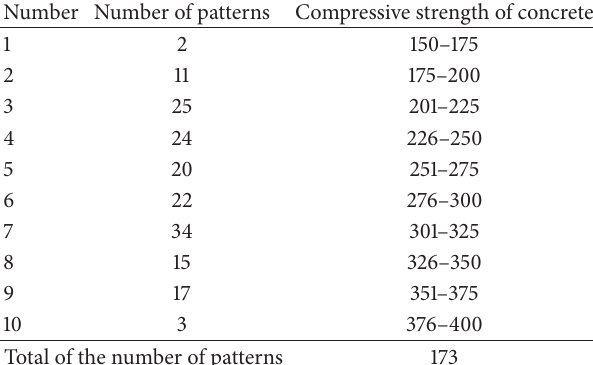
Table 2: Number of patterns used in ANN.